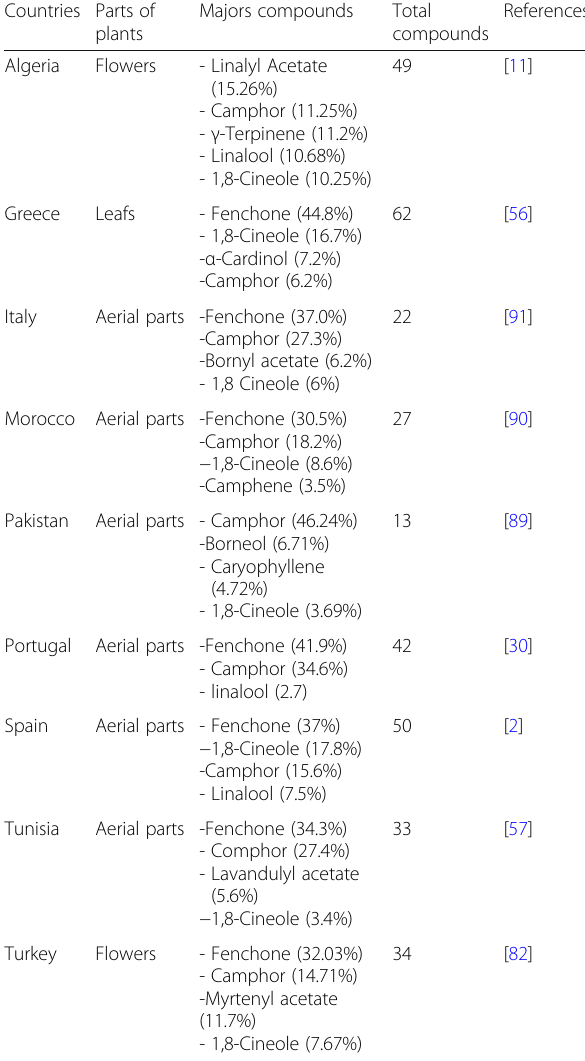
Table 2 Major constituents of volatile oils from L. stoechas Countries Parts of Majors plants